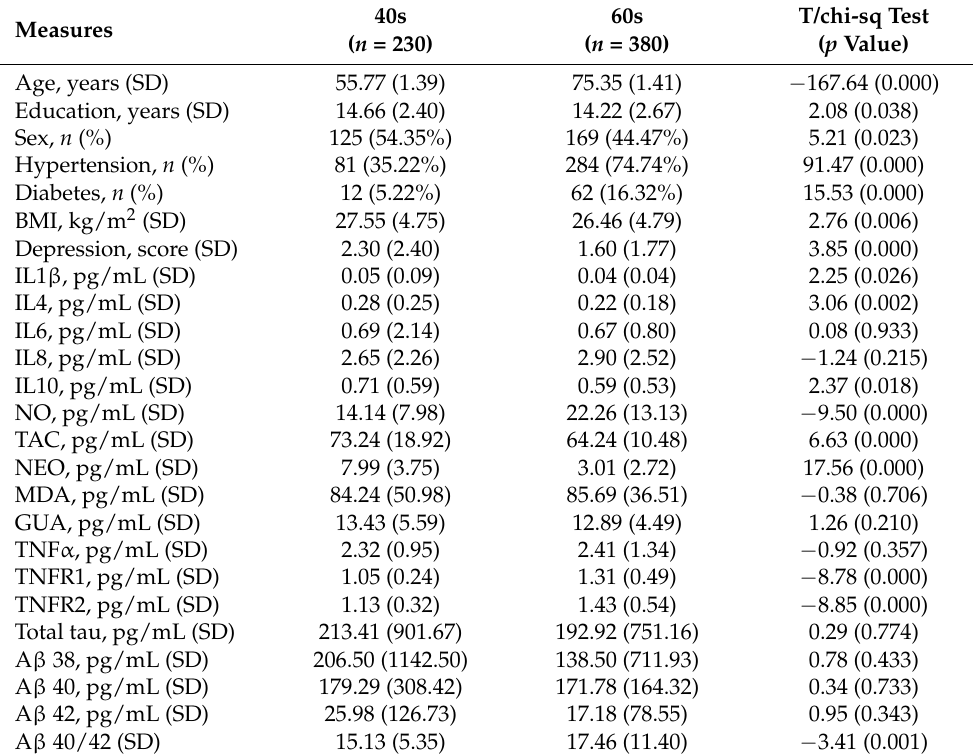
Table 1. Participants’